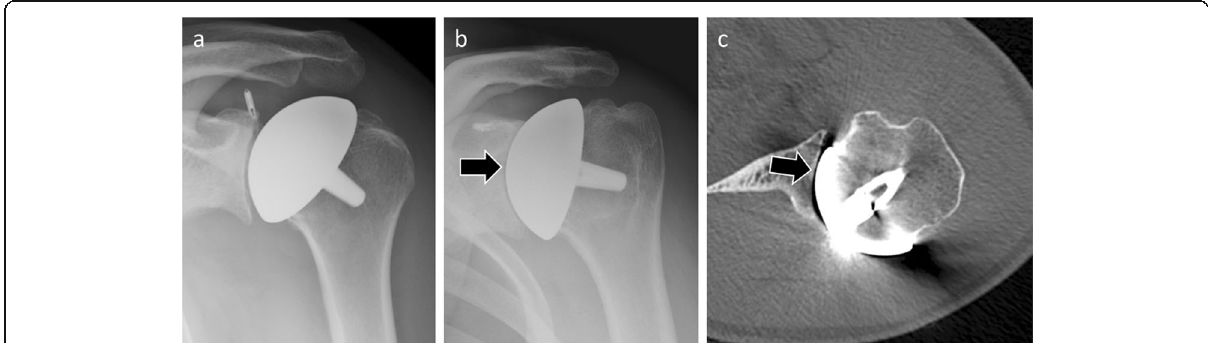
Fig. 21 a Anteroposterior radiograph of a 36-year-old man with humeral head resurfacing arthroplasty. Anteroposterior radiograph ( b ) and axial CT image ( c ) in the same patient as a , 7 years later, show native glenoid wear manifested by narrowing of the glenohumeral spacing (arrows)